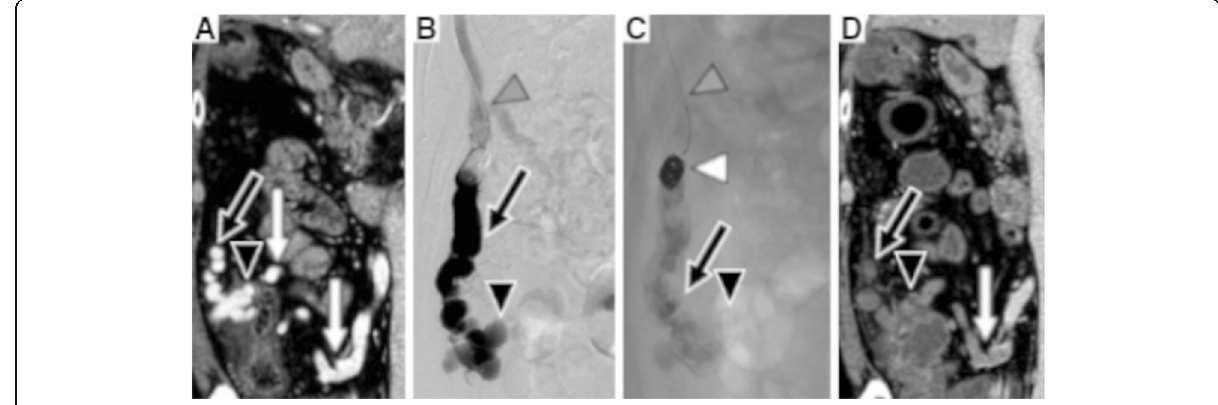
Fig. 3 Close-up pictures of the ascending colonic varix. a Contrast medium-enhanced CT before B-RTO shows the ascending colonic varix (black arrowhead), the main draining vein (black arrow), and the ileocolic vein (white arrows) as a feeder vein. b B-RTV from the main draining vein (black arrow) shows the ascending colonic varix (black arrowhead) and microballoon catheter (gray arrowhead). c After injection of the sclerosing agent, microcoils (white arrowhead) are inserted via the microballoon catheter (gray arrowhead). When the balloon is deflated, contrast medium is retained in the colonic varix (black arrowhead) and the draining vein (black arrow). c corresponds to the enlarged image of Fig. 2b. d The day after B-RTO, contrast medium-enhanced CT shows no enhancement of the draining vein (black arrow), the colonic varix (black arrowhead), and the ileocolic vein (white